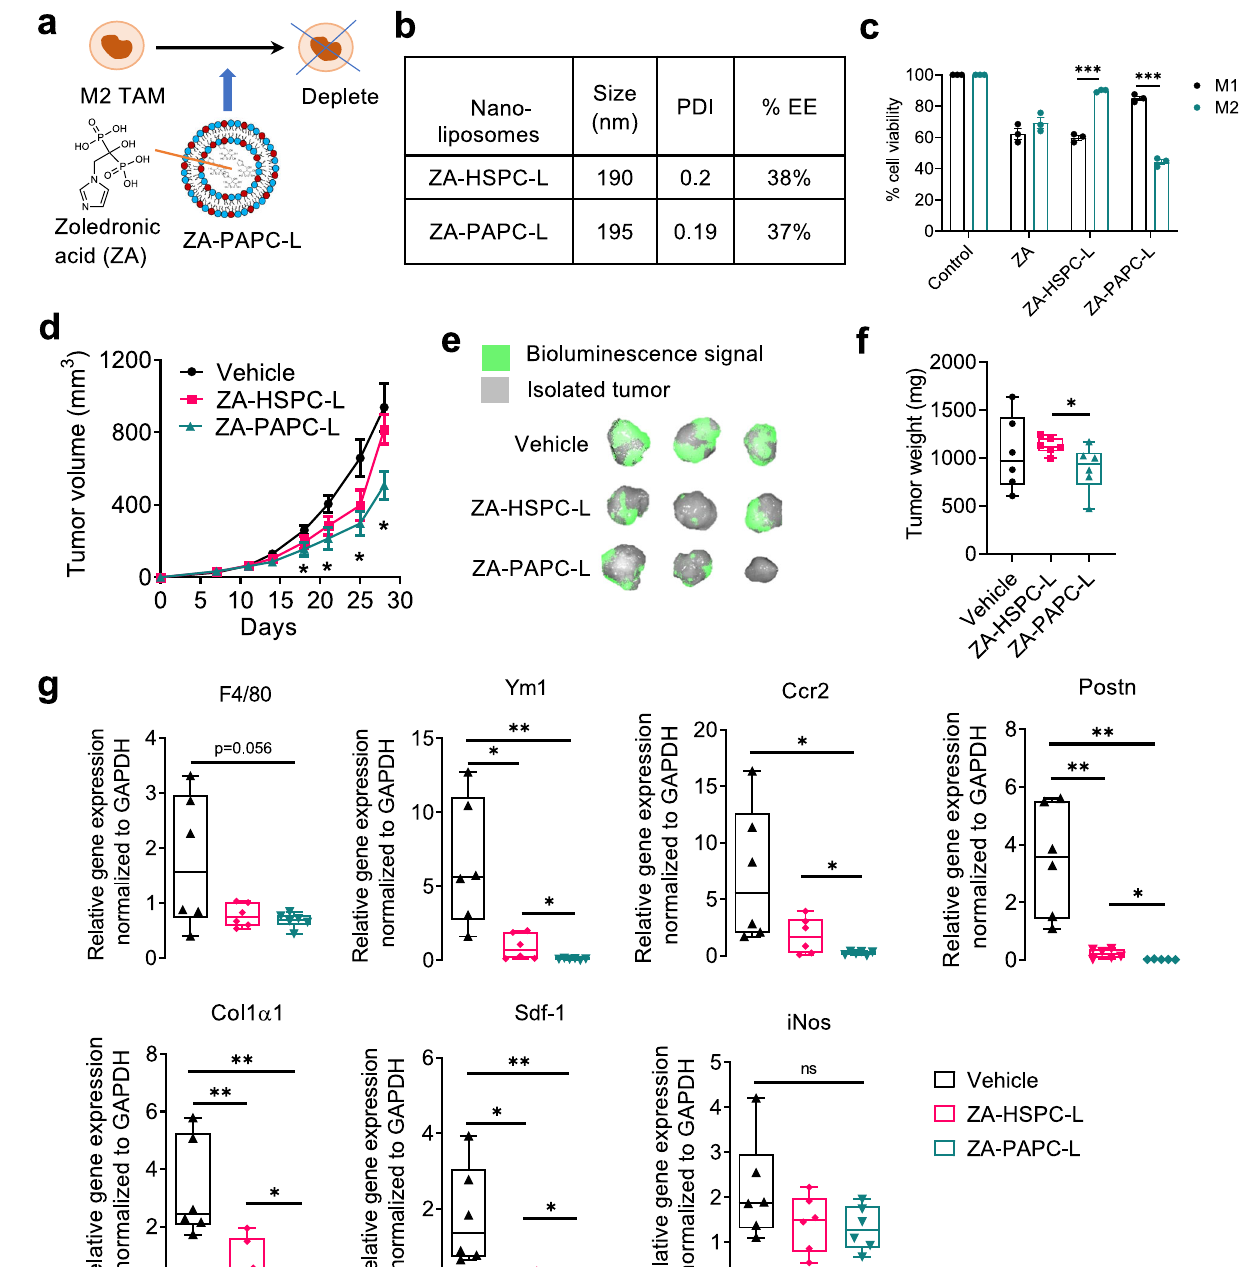
Fig. 7 | Targeting zoledronic acid (ZA) using PAPC-L. a A diagram showing ZA encapsulated PAPC nanoliposomes (ZA-PAPC-L) depleting M2 TAMs. b Physicochemical properties of AS-HSPC-L and AS-PAPC-L and encapsulation ef fi ciency(%EE). c % cellviabilityofTHP-1differentiatedM1andM2macrophages 24h after the treatment of free ZA, ZA-HSPC-L or ZA-PAPC-L (left to right: *** p =0.000043, *** p =0.000049). Data represents mean ± standard error of the mean (SEM) for three independent experiments. Statistical analysis was per- formed with Multiple unpaired t -tests with correction for multiple comparisons usingtheHolm – Sidak ’ smethod. d Tumorgrowthcurvesinorthotopic4T1breast tumor model in mice. Both ZA-HSPC-L and ZA-PAPC-L were injected with dose equivalent to 0.5mg/kg ZA, 100 µ l injection volume, i.v., twice a week, when tumors became ±100 mm 3 . Before sacri fi ce, mice were injected with 2.5mg of D-luciferin and were imaged after 10min to detect bioluminescence signal using Pearl Trilogy imager (LICOR) (left to right: * p =0.049, * p =0.034, * p =0.014, * p =0.018 between Vehicle and ZA-PAPC-L). Mean + SEM, N =6 mice per group,